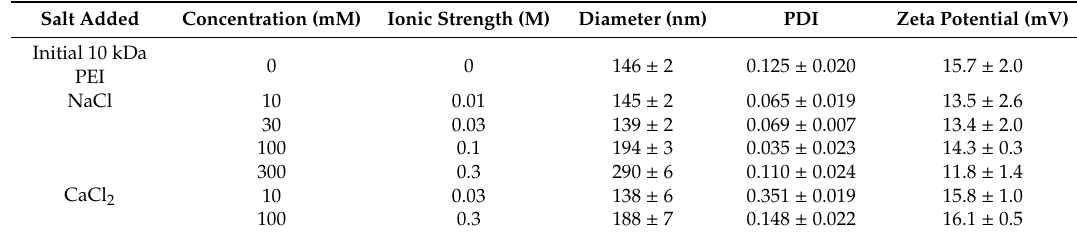
Table 3. E ff ect of ionic strength on 10 kDa PEI nanoparticle properties.